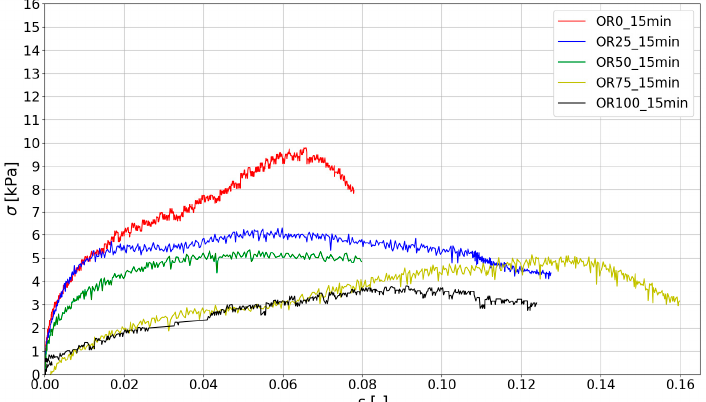
Figure 10. Stress–strain curves for mixes at 15 min after adding water.